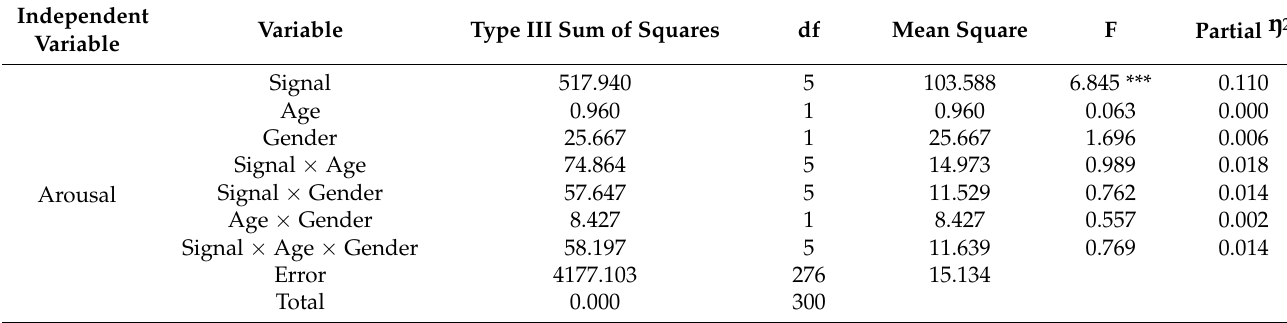
Table 3. The results of three-way analysis of variance (ANOVA) among signal, age and gender in arousal. Independent